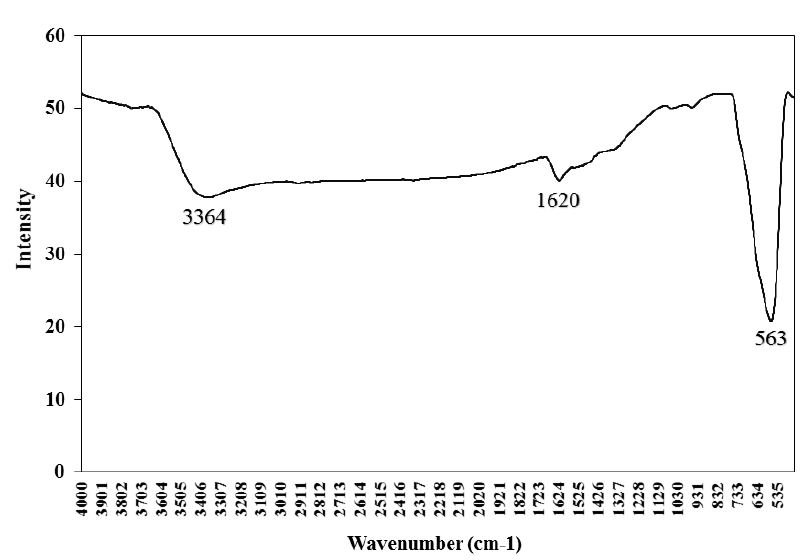
Fig. 7. FT-IR spectra of calcinated ZnFe Figure 7: FT-IR spectra of calcinated ZnFe 2 O 4 nanoparticles.